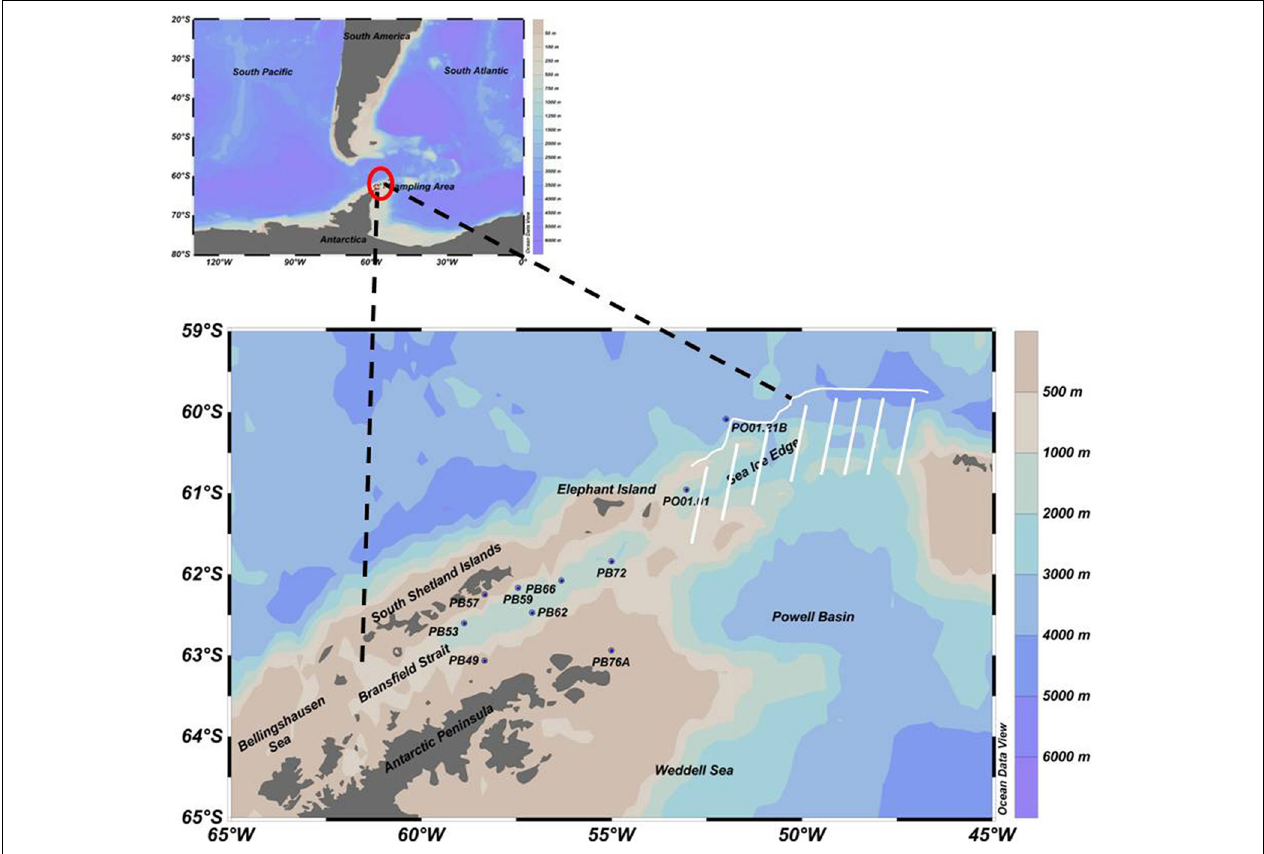
FIGURE 1 | Sampling map with 10 selected oceanographic stations in the Southern Ocean, from the Bransfield Strait (northwest of the AP) to the open oceanneartheseaiceedge(northoftheAP),representedbythewhiteline.